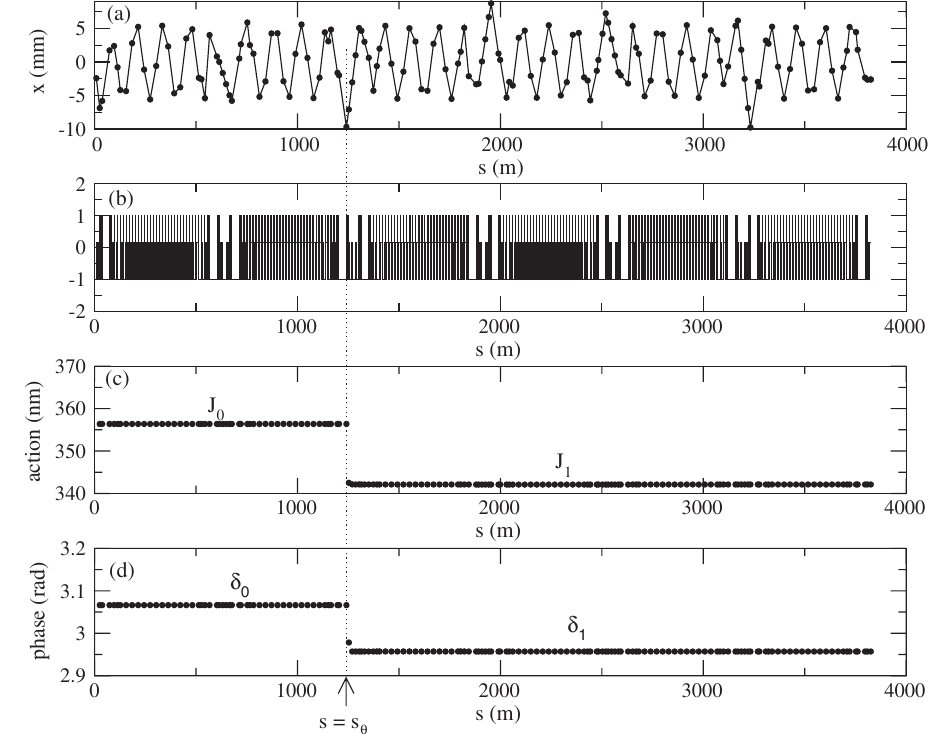
FIG. 1. (a) Simulation of a RHIC first turn trajectory with every dot representing a BPM measurement, in the presence of a magnetic ¼ 1241 m . (b) RHIC optics with short bars representing dipoles and long bars representing quadrupoles. at s kick with strength (cid:1) z (cid:1) (c) Action analysis of the simulated first turn trajectory. (d) Phase analysis of the same